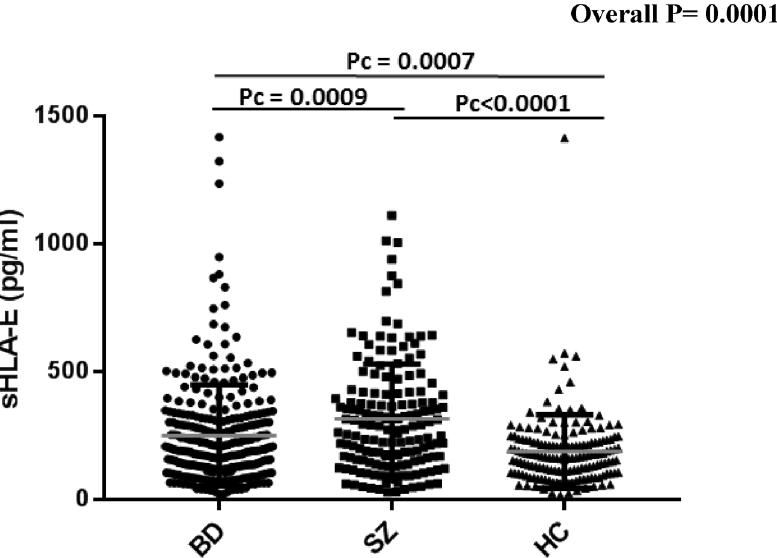
Figure 1. Analysis of the distribution of circulating sHLA-E levels among SZ, BD patients and healthy controls. Statistically significant increase in both patient subgroups (mean sHLA-E: 316.6 vs. 189.3, pc < 0.0001 in SZ vs. HC and 260.9 vs. 189.3, pc = 0.0007 in BD vs. HC) and between SZ and BD patients (mean sHLA-E: 316.6 vs. 260.9, pc = 0.0009 in SZ vs. BD). p value corrected using the Bonferroni test.